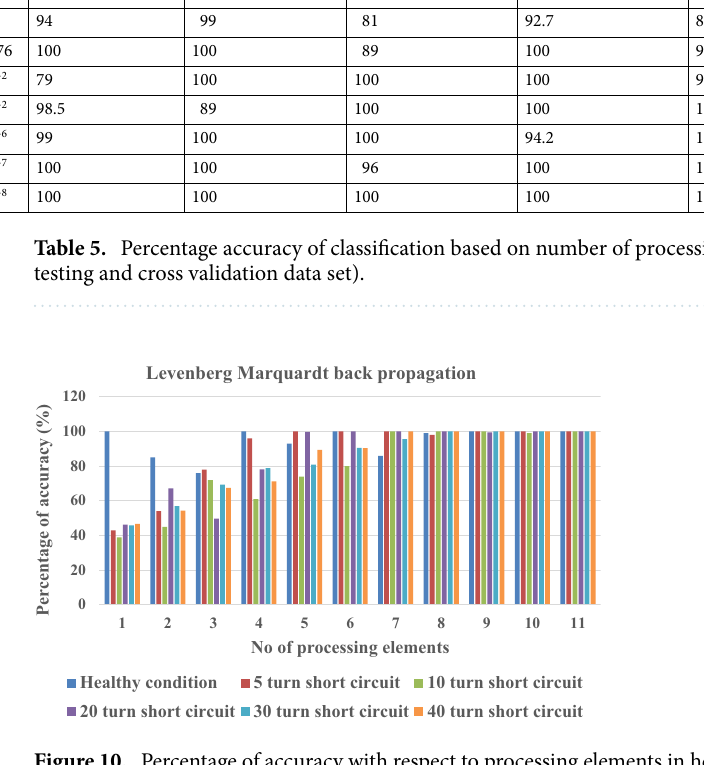
Figure 10. Percentage of accuracy with respect to processing elements in healthy and faulty conditions (training data